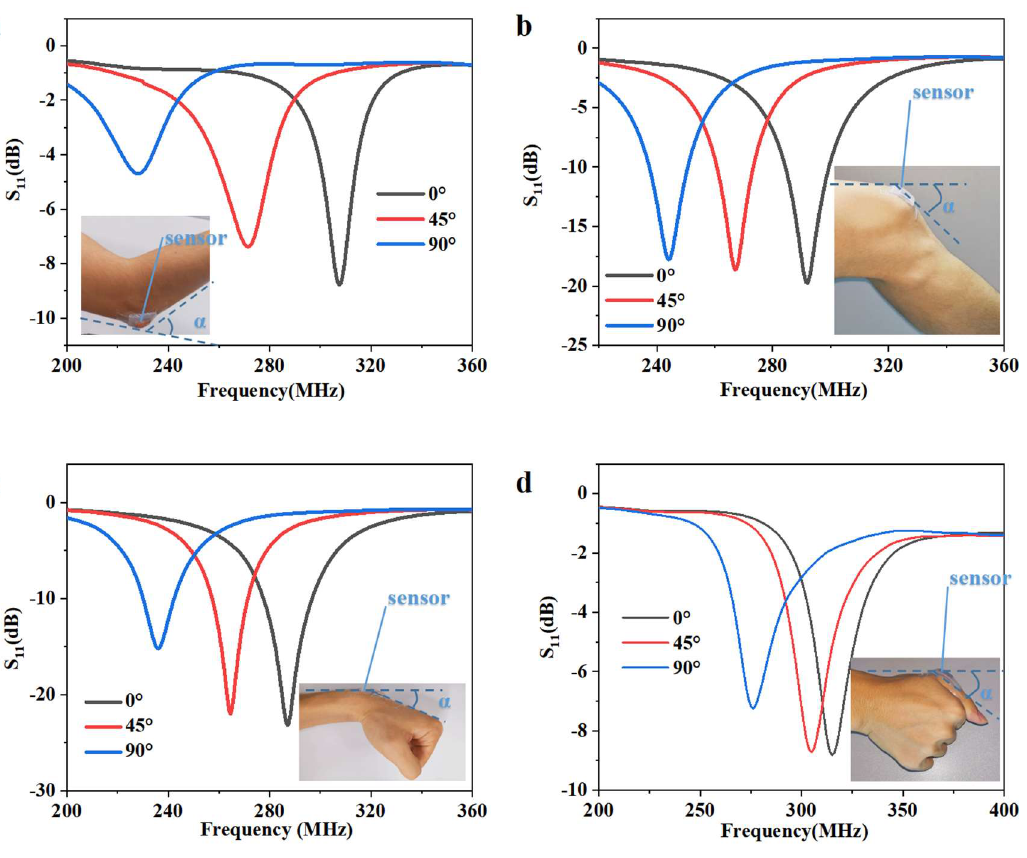
Figure 5. Application in the detection of various human body movements. Responses of the pressure sensor to ( a ) bending an elbow, ( b ) bending a knee, ( c ) bending a wrist, and ( d ) bending a finger.